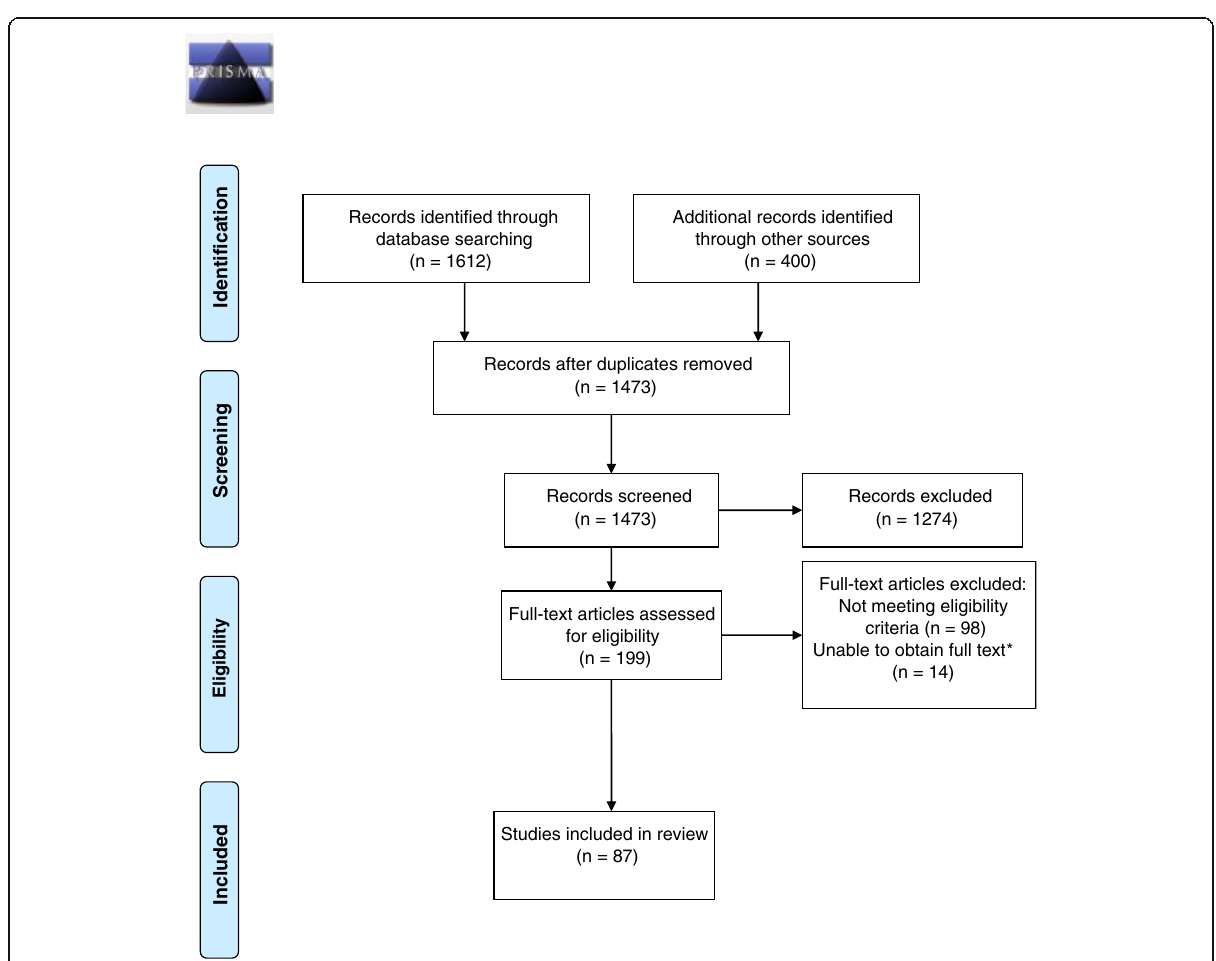
Fig. 1 Flowchart of literature search and screening. *Full text not available through National University of Singapore and London School of Hygiene and Tropical